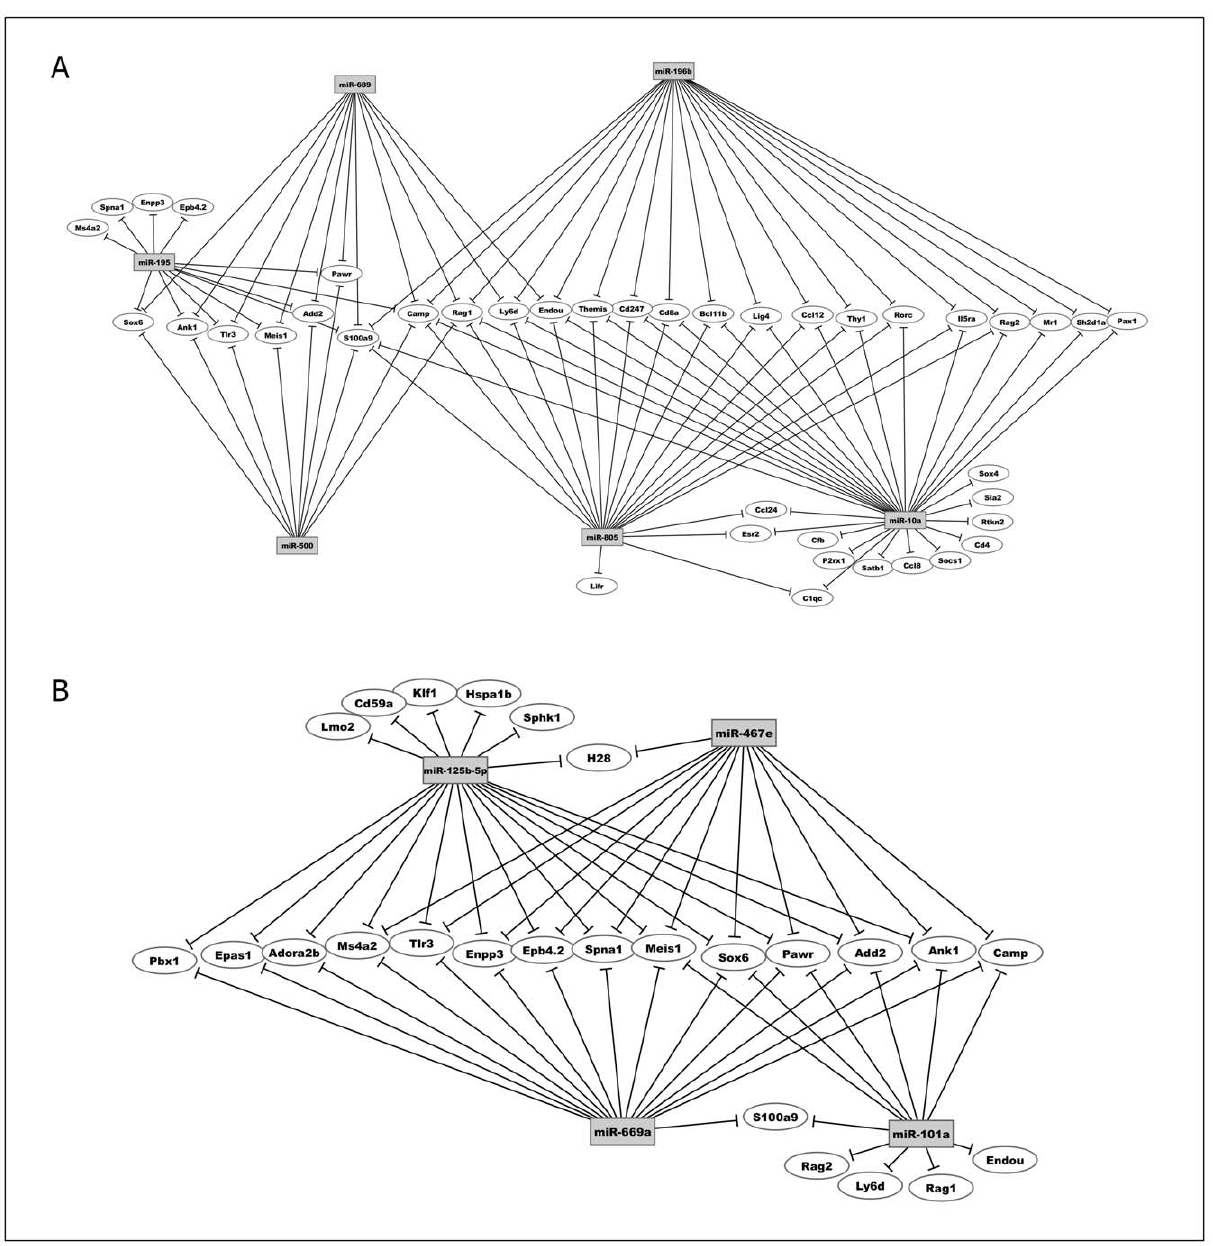
Figure 6. Post-transcriptional miRNA-mRNA interaction networks based on microarray expression data from peripheral CD3 + T cells. The networks were obtained using the GenMir ++ algorithm. This figure shows the participation of A) six miRNAs up-regulated in CD3 + T cells of DBA-1/J strain and B) four miRNAs up-regulated in CD3 + T cells of DBA-2/J strain. These miRNAs interact with mRNAs related to immune system.